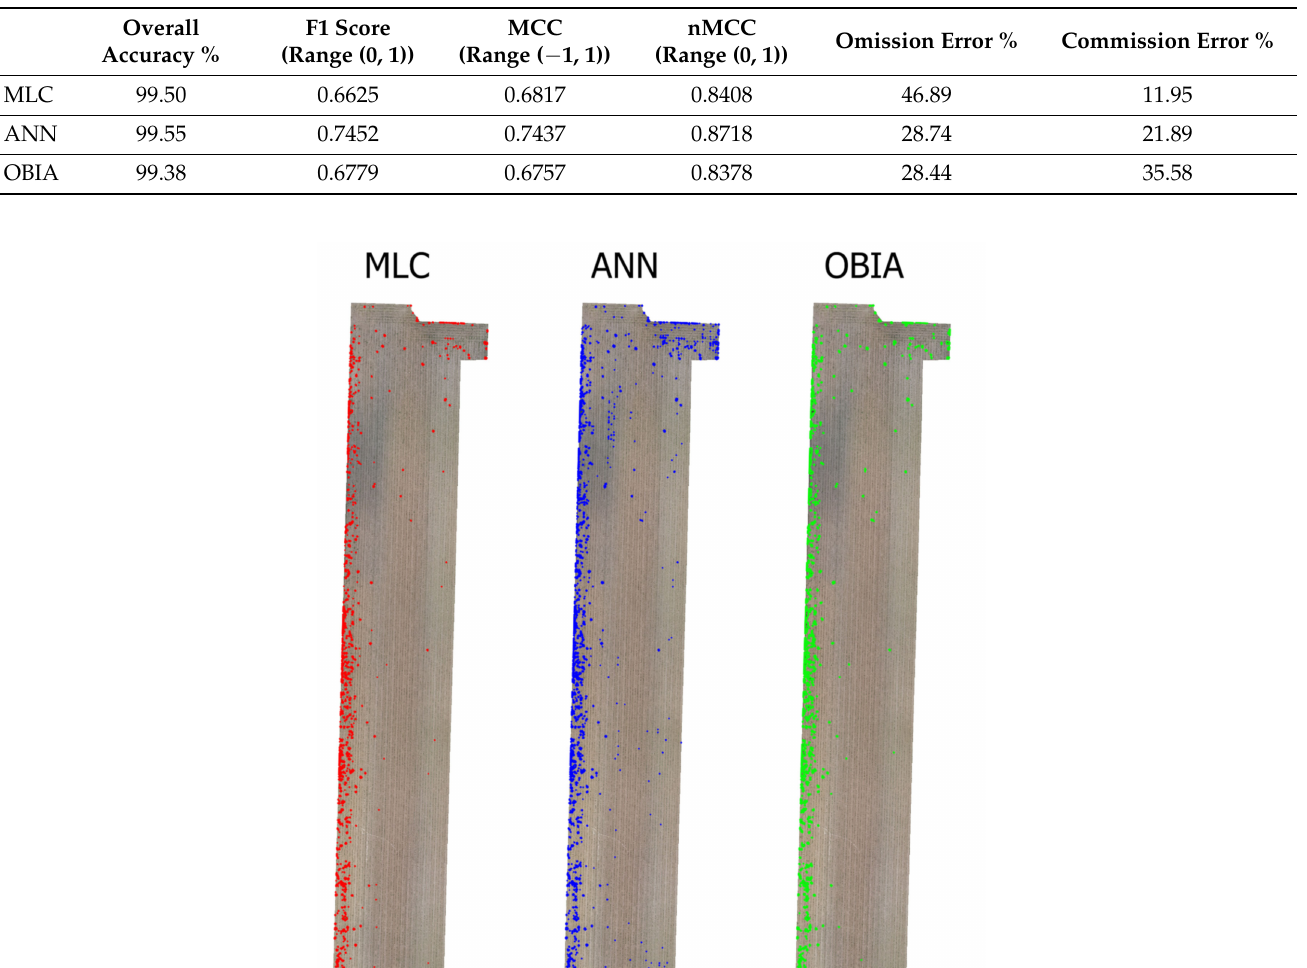
Table 3. Accuracy assessment results summary for the three tested weed detection methods.